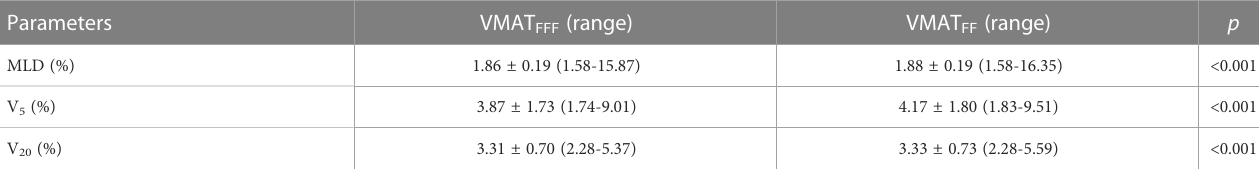
TABLE 5 Comparison of NTCP (mean ± standard)of lung. Parameters